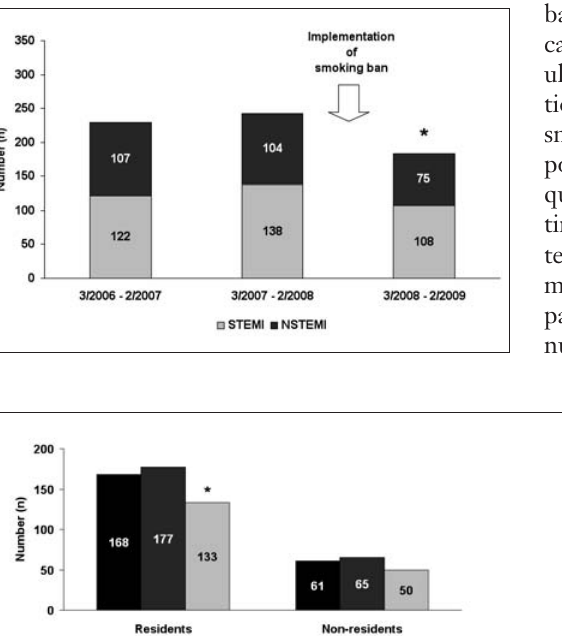
Numbers of patients with ST-elevation myocardial infarction (STEMI) and non-ST-elevation myocardial infarction (NSTEMI) in Graubuenden in the two years before (3/2006- 2/2007 and 3/2007-2/2008) and the year after (3/2008-2/2009) implementation of a public smoking ban. The reduction of the overall myocardial infarction incidence observed after adoption of smoke-free legislation was caused by a similar decrease in the incidence of STEMI and NSTEMI. * p <0.05 vs. each of the two previous 12-month